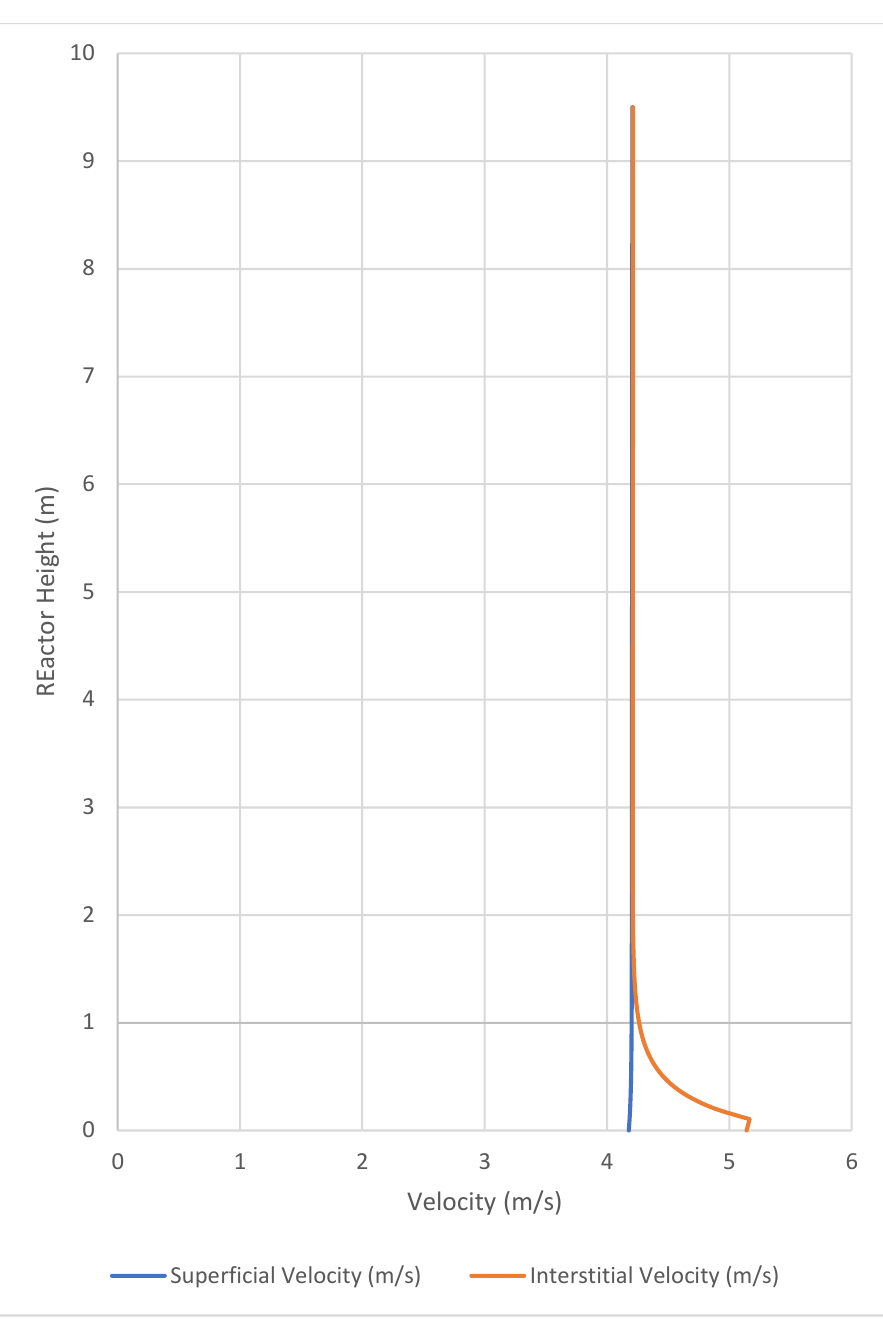
Figure 5. Velocities profiles inside the air reactor, adapted from (using logarithmic scale) [64]. As it can be seen from Figure 5, the bed of the air reactor is full of particles up to the height of 1–2 m; in this way, the interstitial velocity is higher than the superficial velocity and decreases rapidly when the freeboard begins. These numbers are correspondent to the order of magnitude of the velocities, which are reported in Kronberger et al., 2005 [7]. The solids volume fraction in the air reactor is presented in Figure 6.